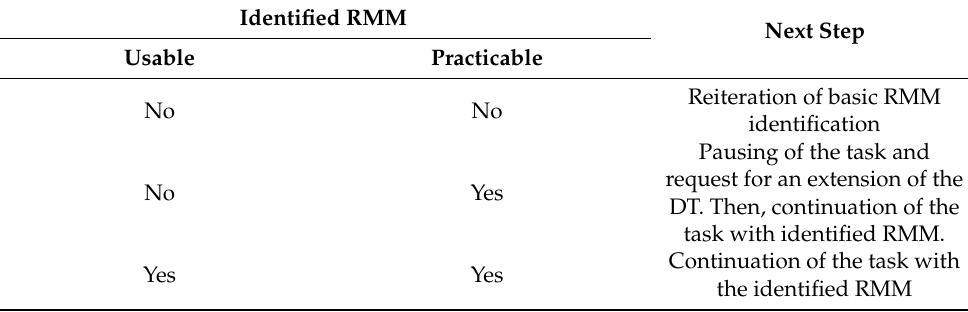
Table 2. Decision matrix about the feasibility of RMM evaluation (usability and